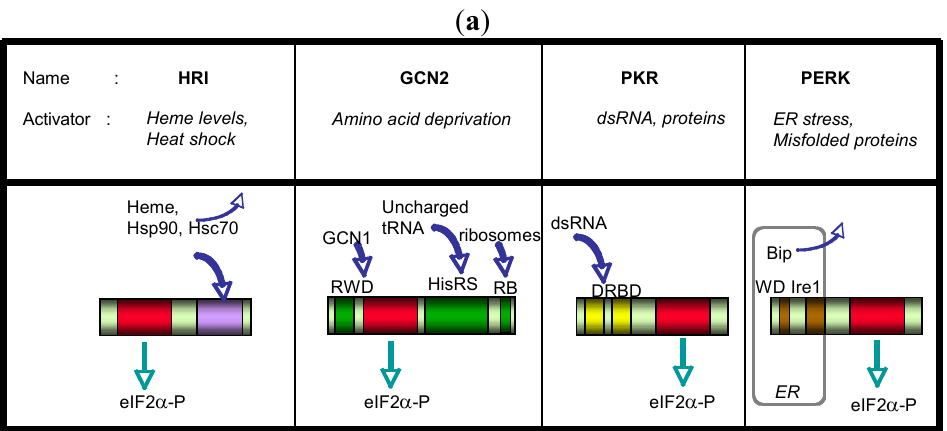
Figure 1. ( a ) The eIF2 α -kinase family. Schematic representation of the four eIF2 α -kinases: HRI, GCN2, PKR and PERK, showing their catalytic domains (in red) located at the N terminus (HRI, GCN2) or C terminus (PKR and PERK). HRI activates in response to diminution of heme levels or binding to some heat shock proteins such as Hsp90 or Hsc70. GCN2 form an inactive dimer through its region homologous to histidyl-tRNA synthetase (HisRS) and becomes activated, by change of conformation, when this domain binds uncharged tRNA, allowing its N-terminal ring finger and WD repeat domain (RWD) to bind GCN1 required for its function. It contains also a Ribosomal Binding site (RB) at its C terminus. PKR activates through two basic domains or dsRNA binding domains (DRBD) located at its N terminus. PERK is maintained in an inactive state through binding to the chaperone Bip protein (also known as Grp78 or Hsp 70-5) at its luminal N terminus (on WD repeats and Ire1-like domain). Unfolded proteins appearing in the lumen during ER stress attract Bip, which allows PERK homodimerization and activation of its cytosolic kinase domain. ( b ) PKR structure and mode of activation. The two 73 aa dsRNA Binding Domains (DRBD1 and DRBD2), located at the N terminus of PKR (purple) are responsible for the binding of PKR to its regulators. Mutation of the K296 residue (in subdomain II of the 253–525 catalytic domain; white bars) is sufficient to abrogate the catalytic activity of PKR. The sequences of the TRAF binding sites (grey bars) and nuclear export sequences (NES; yellow bars) is as indicated in the upper box. The eIF2 α substrate binds in the helical C-lobe of PKR (blue bar) and the activation segment (black) contains the threonines 446 and 451. Lower box: Representation of the activation process of PKR upon binding to dsRNA. After binding of the first DRBD to dsRNA, binding of the second DRBD stabilizes the dsRNA/PKR complex and opens the conformation of PKR. This allows PKR dimerization through the N-lobe of its kinase domain (blue). PKR dimers activate each other by transphosphorylation of their T446 and T551 residues (red stars). The substrate (here eIF2 α ; green) can then access to its docking site and is positioned correctly within the catalytic domain of PKR where its acceptor site (yellow star) can receive the phosphate from